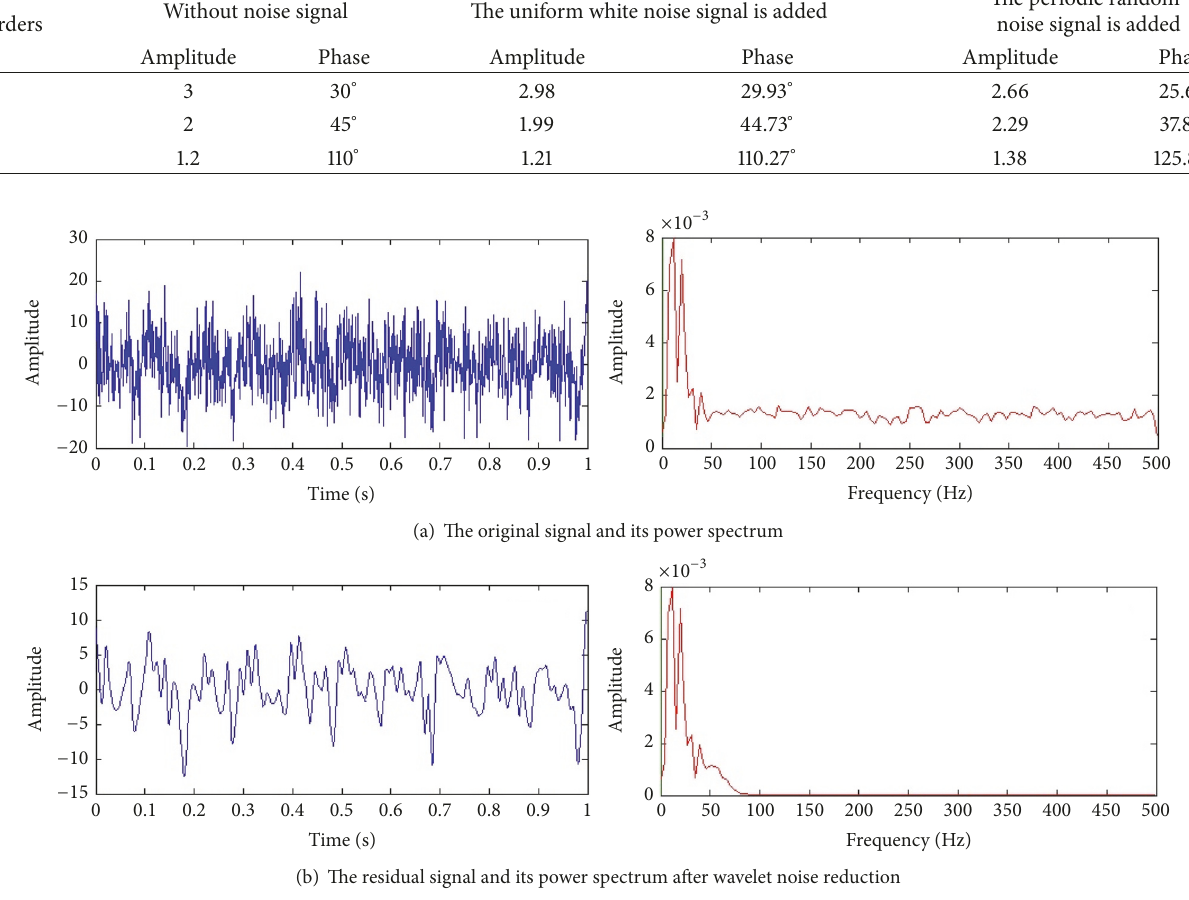
Figure 2: The filtering effect of wavelet noise reduction